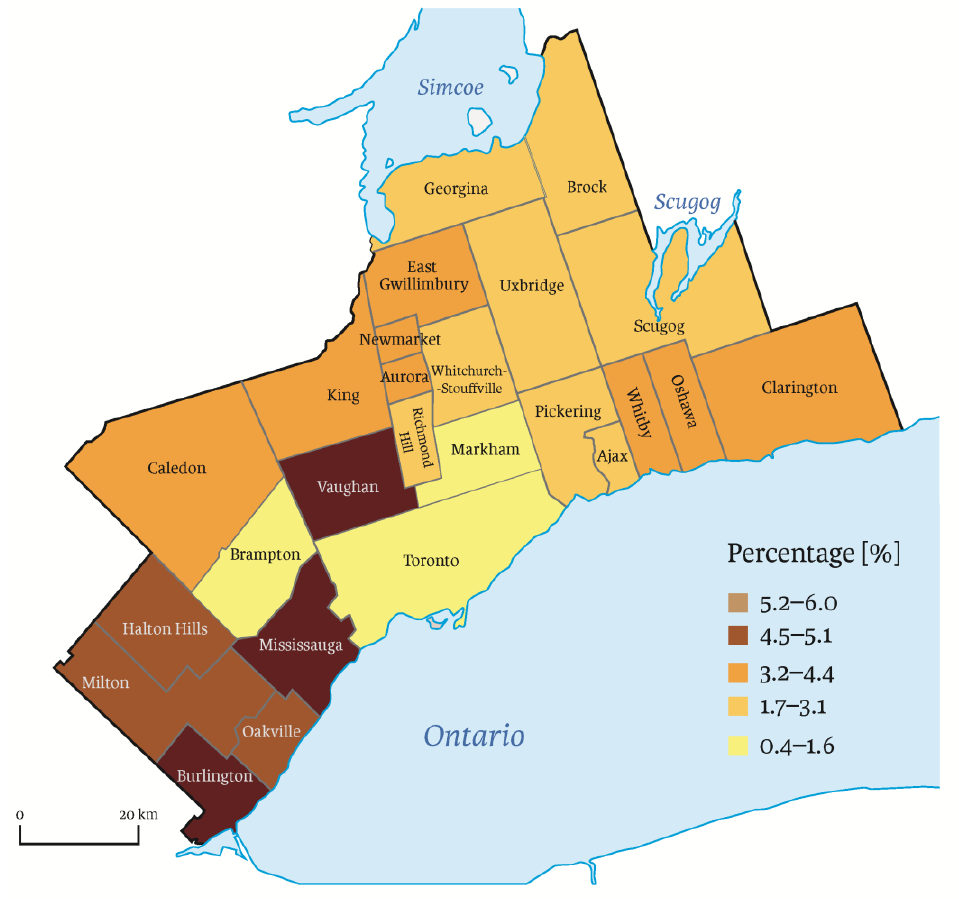
Figure 1. Percentage of Polish people in the Greater Toronto Area in relation to the total population of the area. (Source: Author’s own compilation based on the conducted research.) As more immigrants came from Poland, and as a result of the functioning of migration social networks, significant concentrations of Poles were formed in Toronto. Consequently, “Polish blocks of flats” were created, e.g., in the vicinity of Lakeshore Street at Lake Ontario, but also in the blocks of flats in Scarborough and other districts of the city and in Mississauga adjacent to Toronto. In the latter, a large concentration of Poles lived in the vicinity of the Maximilian Kolbe Polish Church. The Polish district along Roncesvalles Street in Toronto also constituted a place where many Poles were